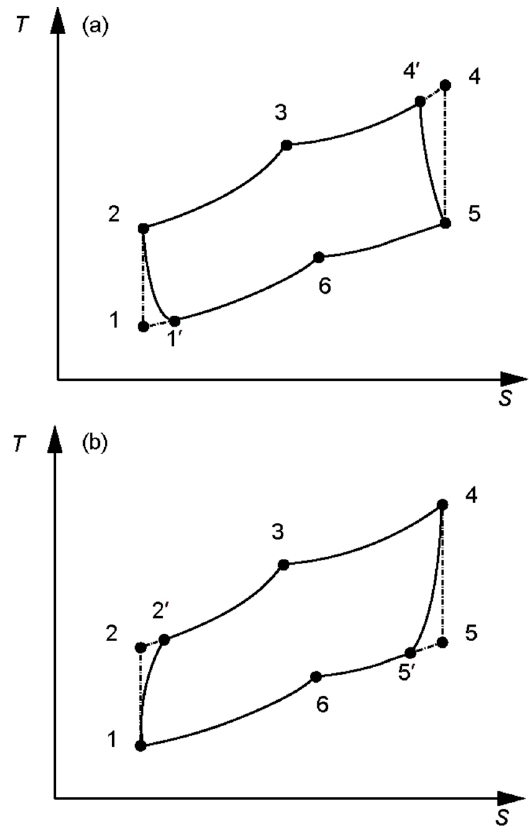
Figure 1. T - S diagram of Dual-Miller cycle (DMC): n less than the k ( a ) and n higher than the k ( b ) [102].